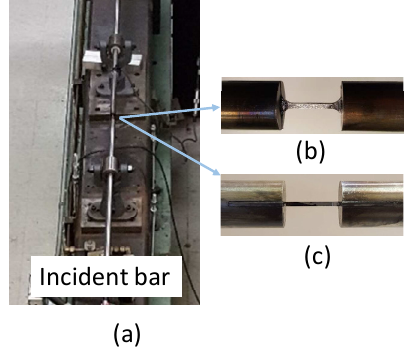
Fig. 4. TSHB apparatus used for this work. Insets b) and c) show side and top views of the sample bonded in